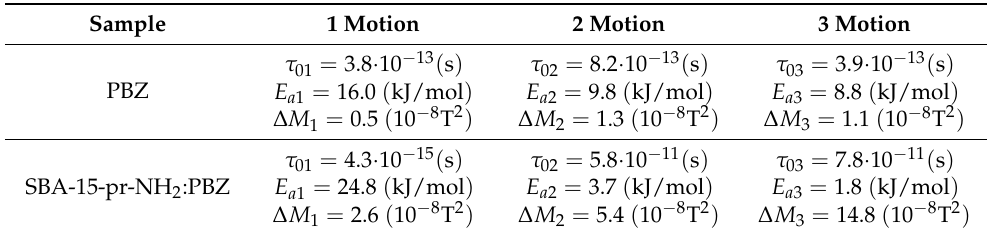
Table 2. The activation parameters of internal group reorientation of PBZ and SBA-15-pr-NH 2 :PBZ. The values of the uncertainty of the estimated parameters were lower than